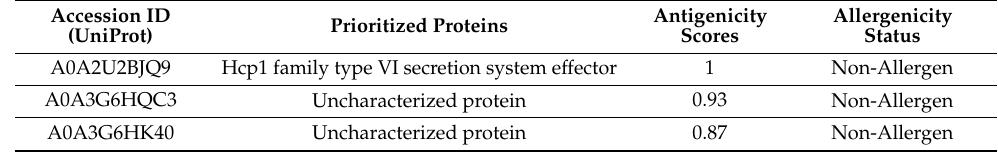
Table 1. The three prioritized target proteins with demonstrated highest antigenicity scores.